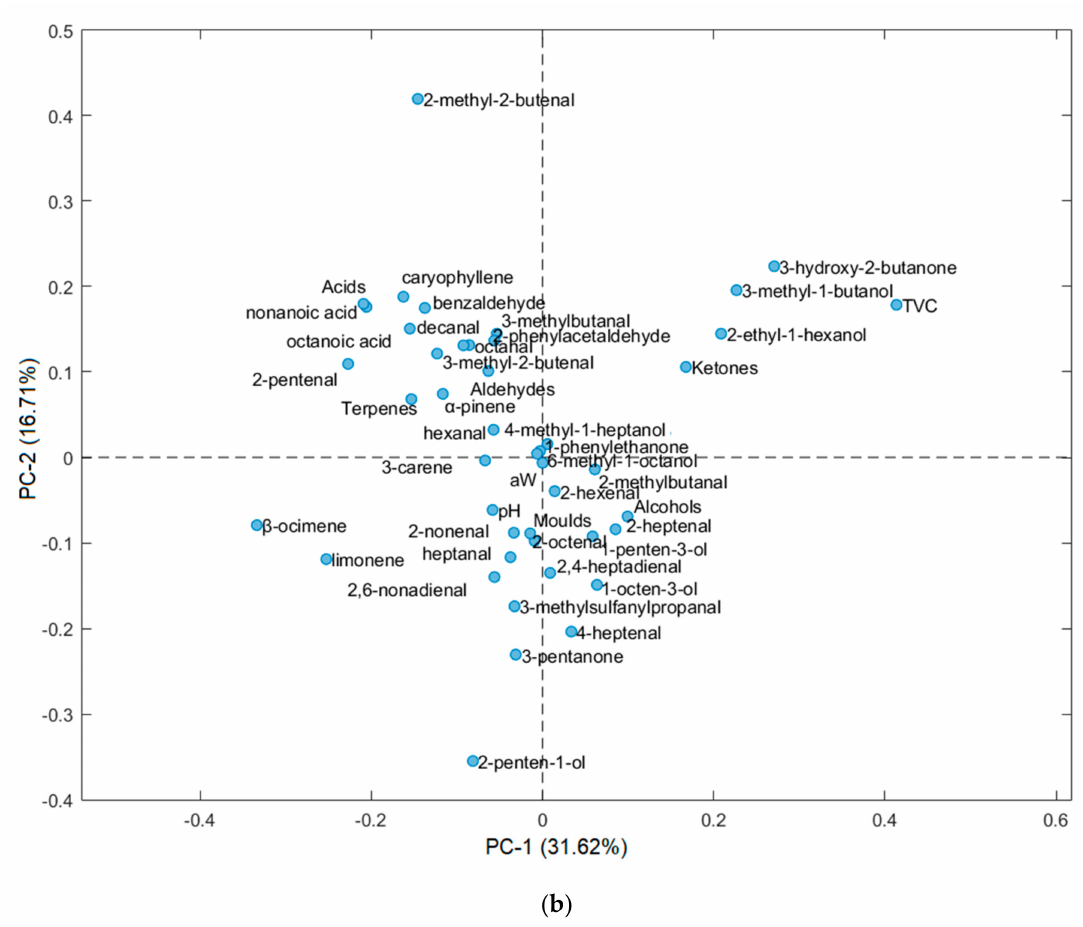
Figure 1. ( a ) Score plot of caviar samples analyzed in the study obtained by a multilevel principal component analysis (multilevel-PCA). t-0 = unripened roes, t-1 = 4 months of caviar ripening, t-2 = 8 months of caviar ripening, t-3 = 14 months of caviar ripening. ( b ) Loading plot of parameters measured in analyzed caviar samples obtained by multilevel-PCA. Variables associated with higher loadings on the 1st or the 2nd principal component (PC-1 and PC-2 on the x and the y axis, respectively) are related to a higher influence on variability recorded among samples in the multiple level data